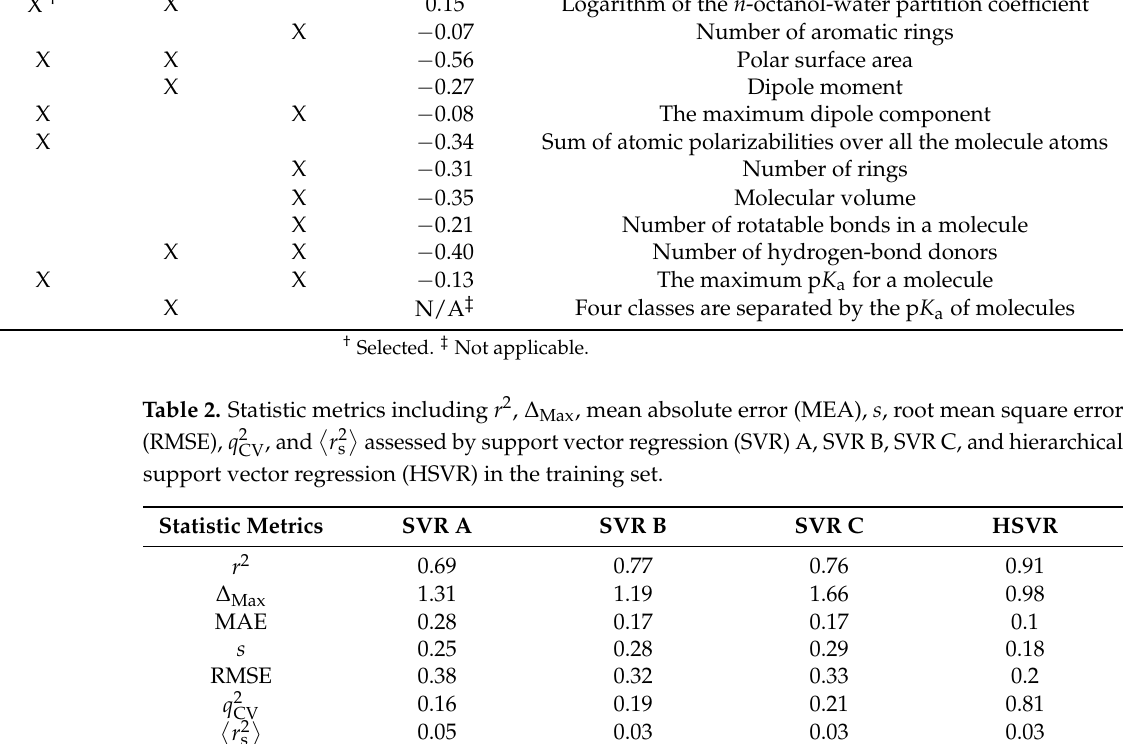
, q 2 , q 2 CCC , ∆ Max , MAE, s , and RMSE assessed by SVR F2 F3 F1